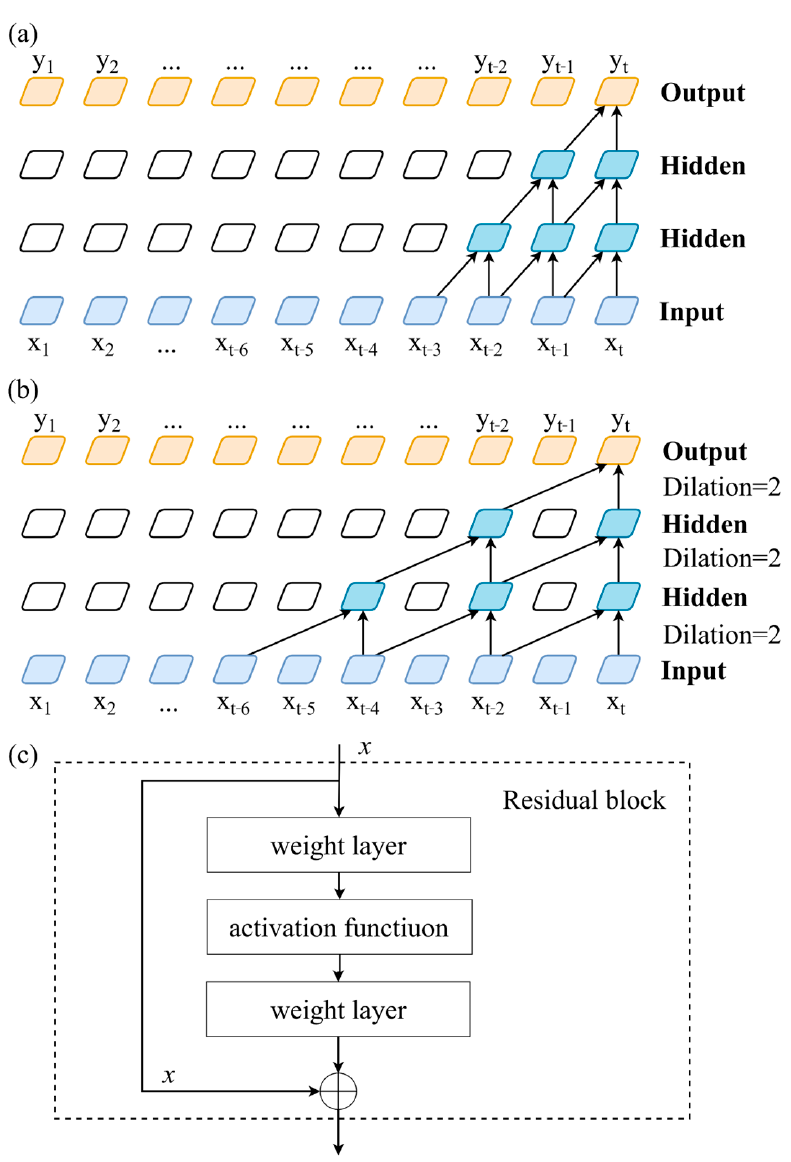
Figure 4. Architectural elements in a TCN: ( a ) causal convolution; ( b ) dilation convolution; ( c ) residual block.